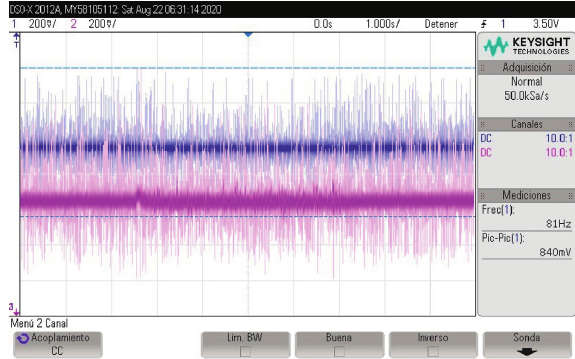
Figure 18: Desired current (blue) and measured current (magenta) for the SSTA controller.